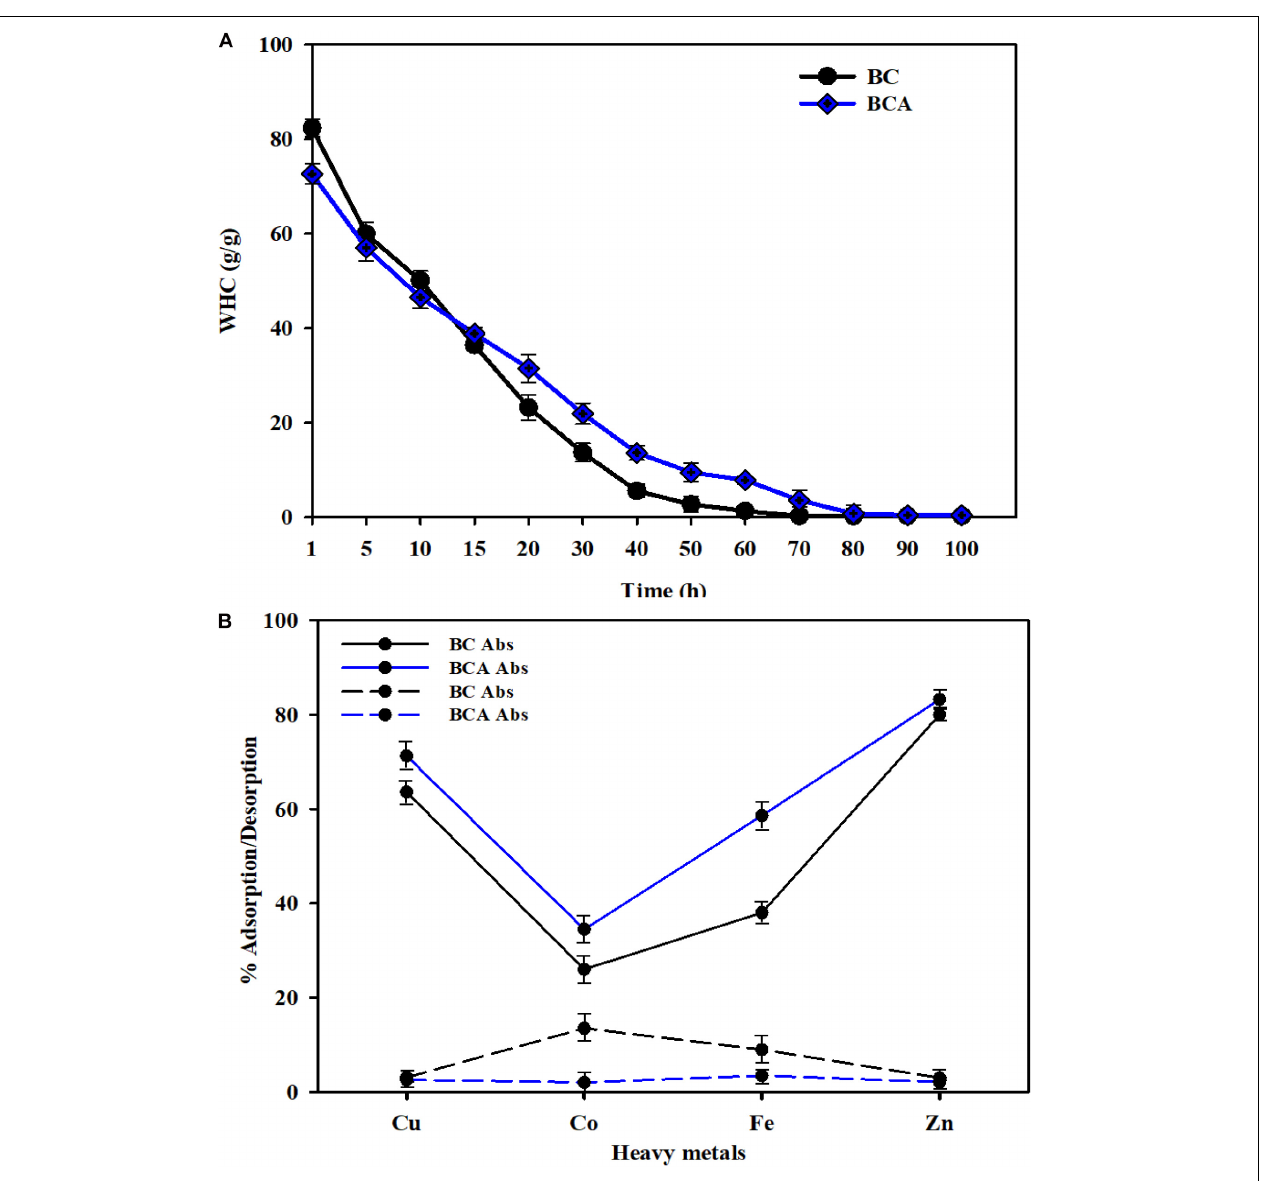
FIGURE 6 | Absorption analysis of pristine BC and ex situ developed Aloe vera -loaded-BC composite (i.e., BCA). (A) Water holding capacity (B) heavy metal absorption analysis for all samples was carried out at room temperature. Error bars indicate that the results are the mean from three independent experiments.